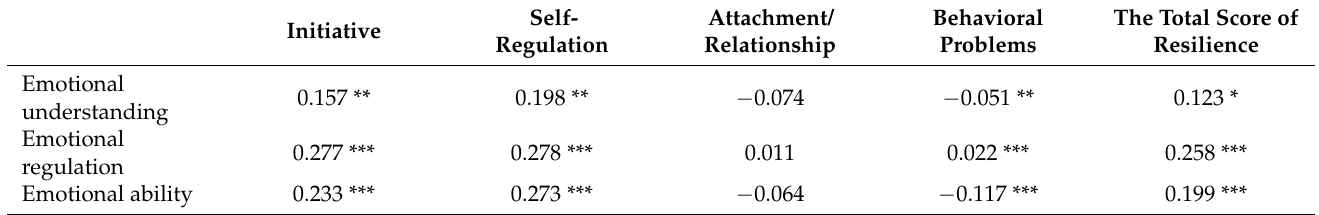
Table 6. Correlation analysis of emotional ability and resilience.